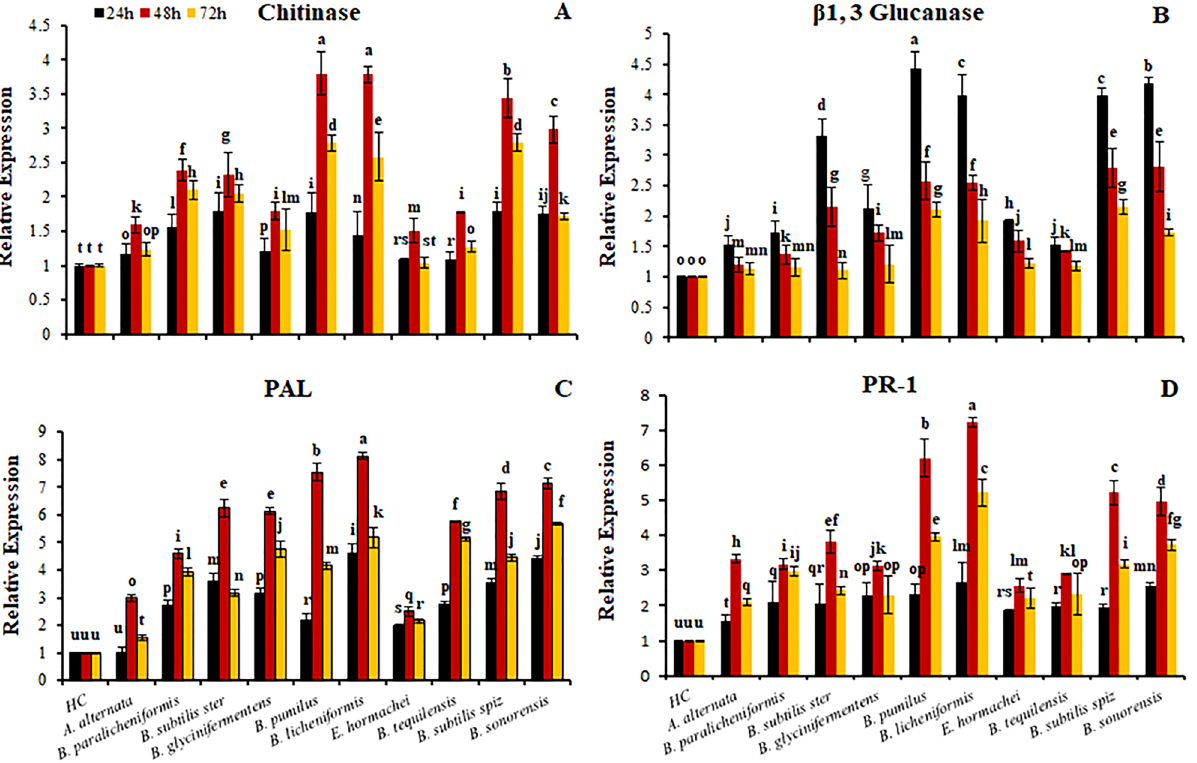
Figure 5. Rhizobacteria-mediated differential expression of defense-related genes in tomato infected with Alternaria alternata . All values are means of three replicates.